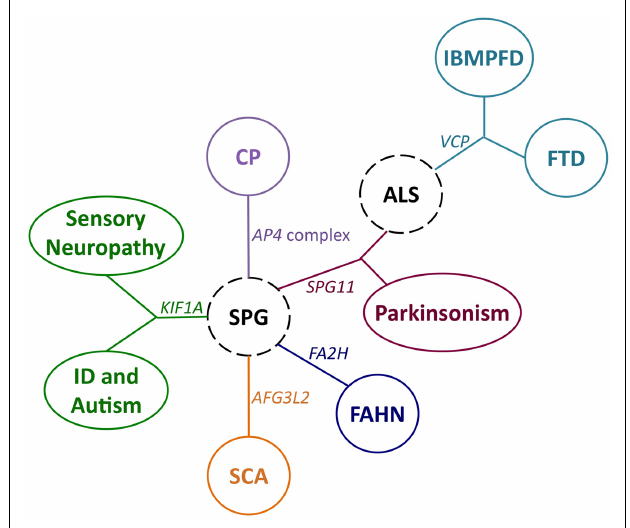
FIGURE 1 | Movement disorder genes associated with multiple neurological phenotypes. Diseases and phenotypes are represented with circles and ovals with genes involved shown between implicated diseases. Dashed circles represent disorders in which more than one gene is involved. Disease abbreviations are described in the main